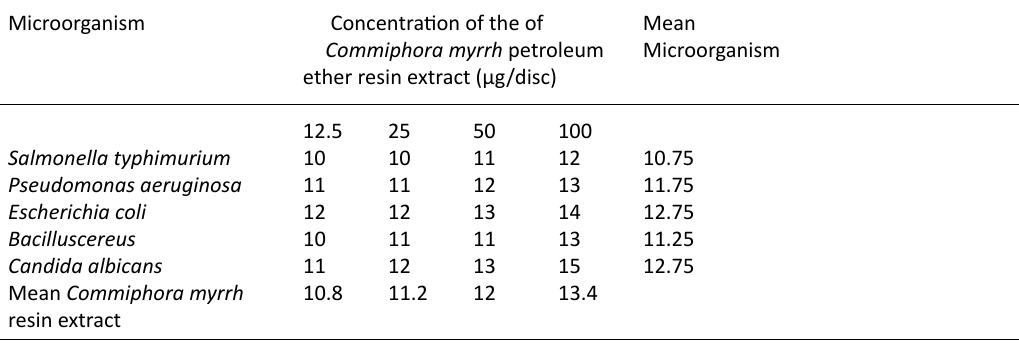
Pseudomonas aeruginosa